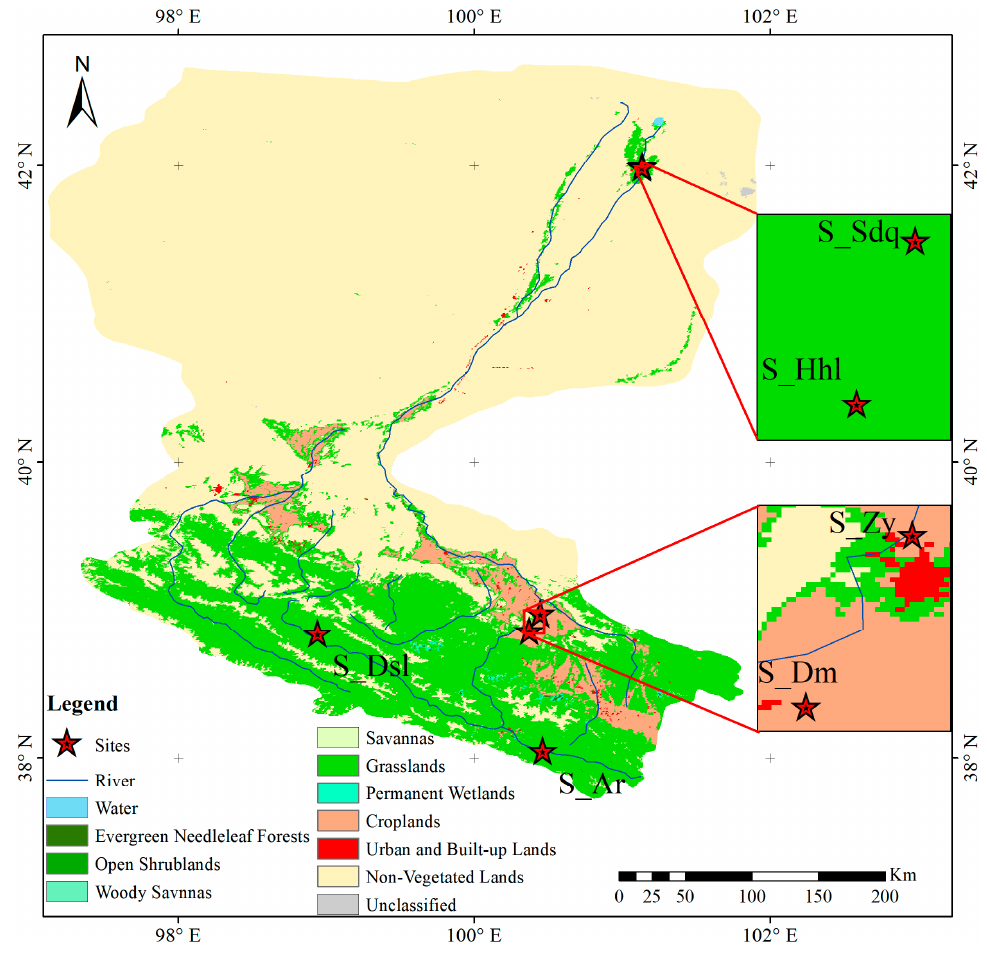
Figure 7. MCD12Q1 land cover types at each flux site in 2014. The data is from https://lpdaac.usgs.gov/.